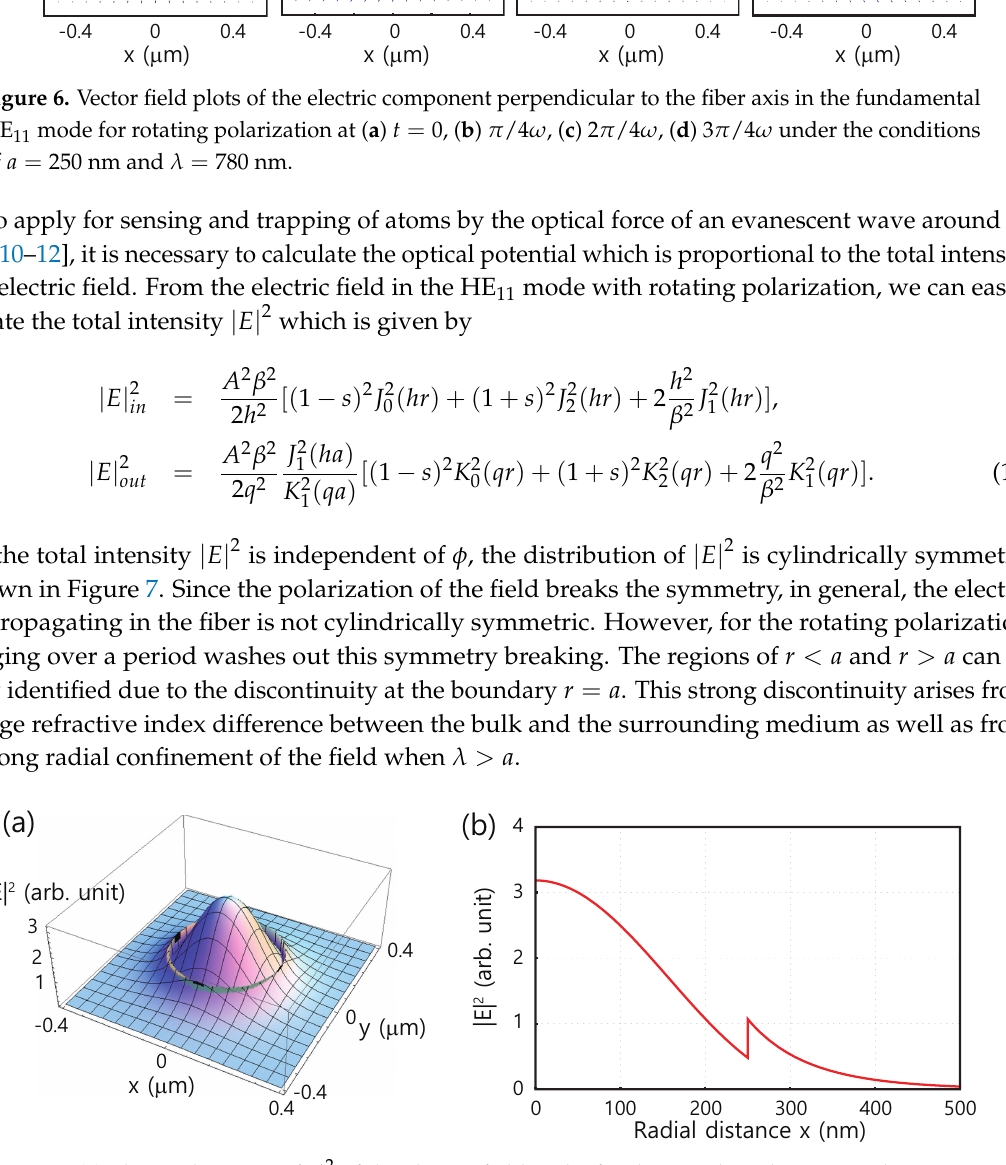
Figure 7. ( a ) The total intensity | E | 2 of the electric field in the fundamental mode HE 11 with rotating polarization. ( b ) Radial dependence of the total intensity | E | 2 of the electric field. Parameters are same as used in Figure